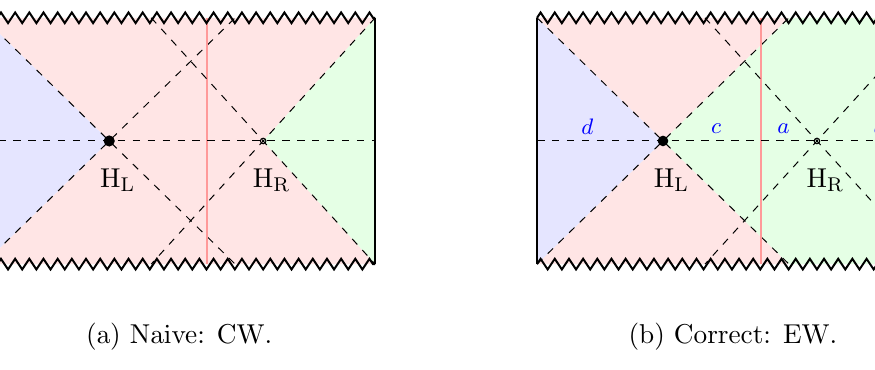
Figure 11 . Dual geometry to a PETS created by acting with a heavy operator during euclidean evolution. We indicate the region reconstructed by the left QM by blue and by the right QM by green. The reconstruction of the red region requires both sides. Naively, each side can only see its causal wedge (CW). Instead, we argue below that each side can in principle reconstruct the full entanglement wedge (EW). The right EW includes regions a; b and c